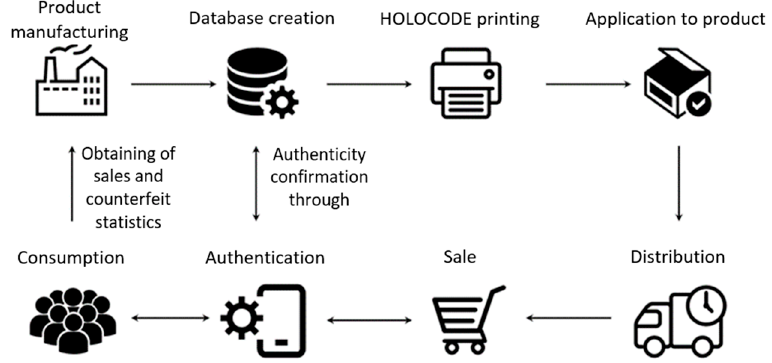
Figure 3. B2C interaction model with the use of Holocode.